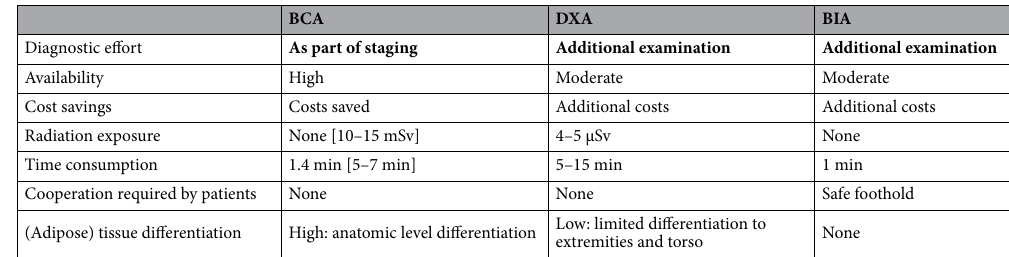
High: anatomic level differentiation Low: limited differentiation to extremities and Table 2. Arguments for and against the methods for BC assessment are summarized and compared to DL-based BCA performed on routine staging CT-scans. The row highlighted in bold points out the intended integration of the method into the diagnostic process relating to the rows following underneath. The details written in square brackets state the respective information concerning the CT-scan, which is used for BCA.